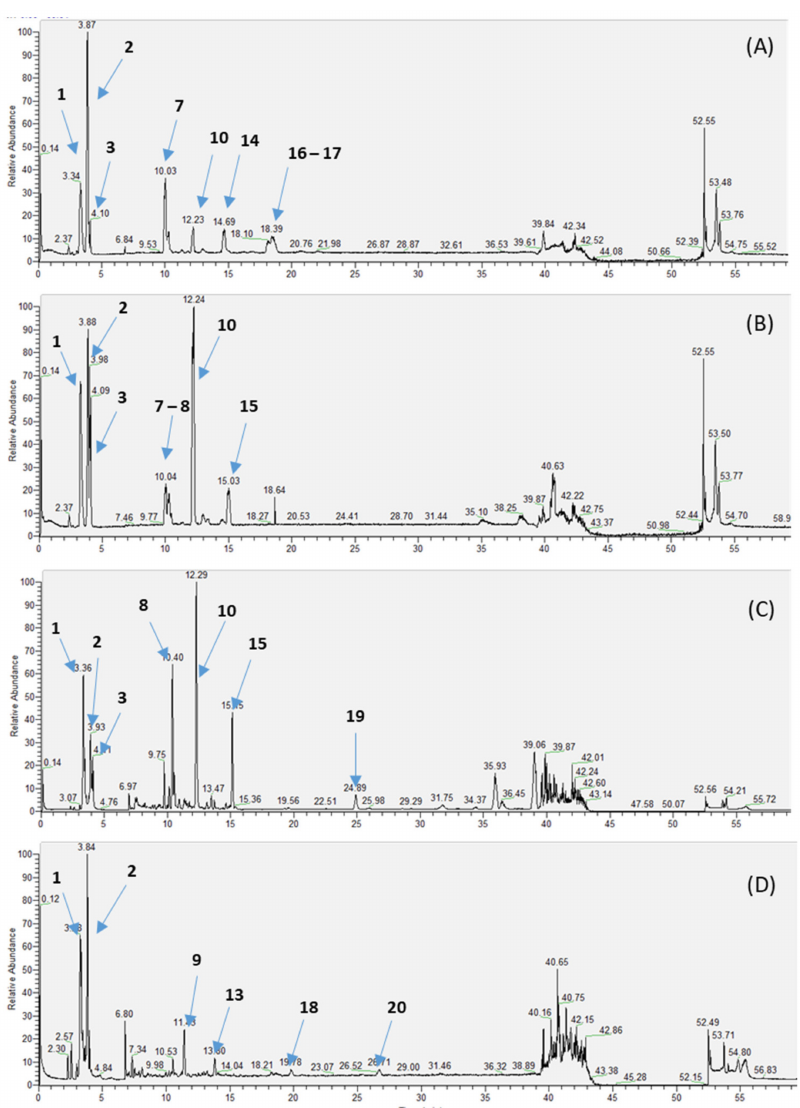
Figure 3. LC-MS chromatograms of C. febrifuga methanolic extracts: ( A ) leaves; ( B ) trunk bark;